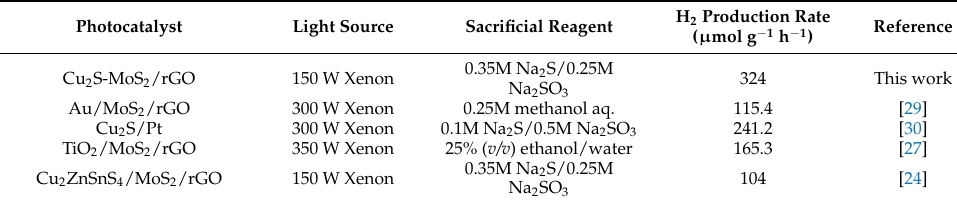
Figure 4. ( a ) Comparison of photocatalytic H 2 evolution from Cu 2 S (Cu 2 S nanorods: Cu 2 S NR; Cu 2 S nanoplates: Cu 2 S NPL; Cu 2 S nanoparticles: Cu 2 S NP), Cu 2 S-rGO, Cu 2 S-MoS 2, and Cu 2 S-MoS 2 /rGO composites. Experimental conditions: 1-h irradiation by solar simulator (150 W Xe lamp, 100 mW cm − 2 ); ( b ) photocatalytic H 2 evolution by Cu 2 S-MoS 2 /rGO composites in a 9-h reaction. The composition of photocatalyst: 85 wt% Cu 2 S, 13 wt% MoS 2 , and 2 wt% rGO. Table 1. Comparative photocatalytic hydrogen evolution with reference photocatalysts.